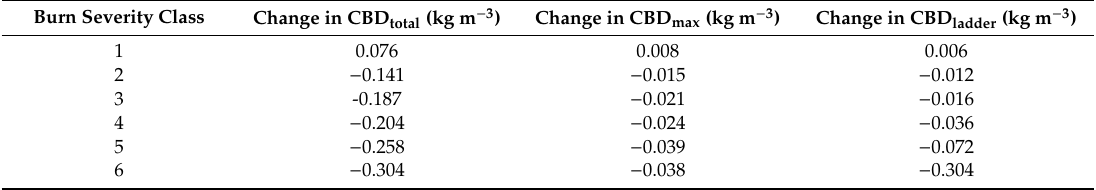
Table 5. Summary CBD total , CBD max and CBD ladder value by burn severity class.